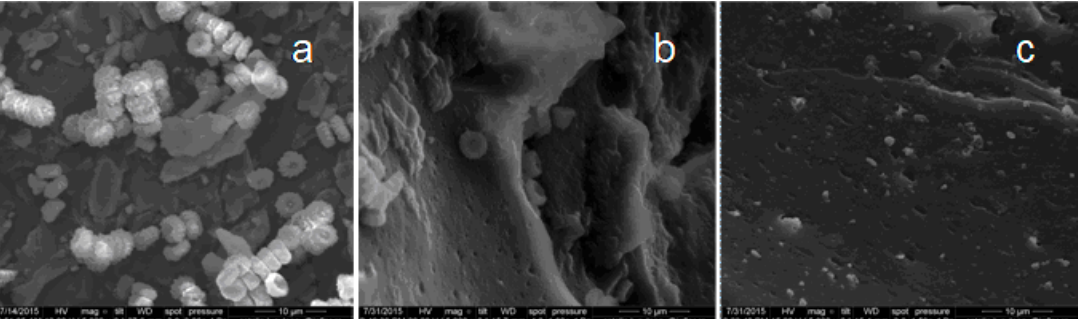
Figure 18. SEM of the B-1 composite. ( a ) after 60 days of incubation with Aspergillus niger ; ( b ) after 60 days of incubation with Aspergillus niger and after 72 h immersed in toluene; ( c ) the blanks (before incubation with the Aspergillus niger ) and after 72 h immersed in toluene.